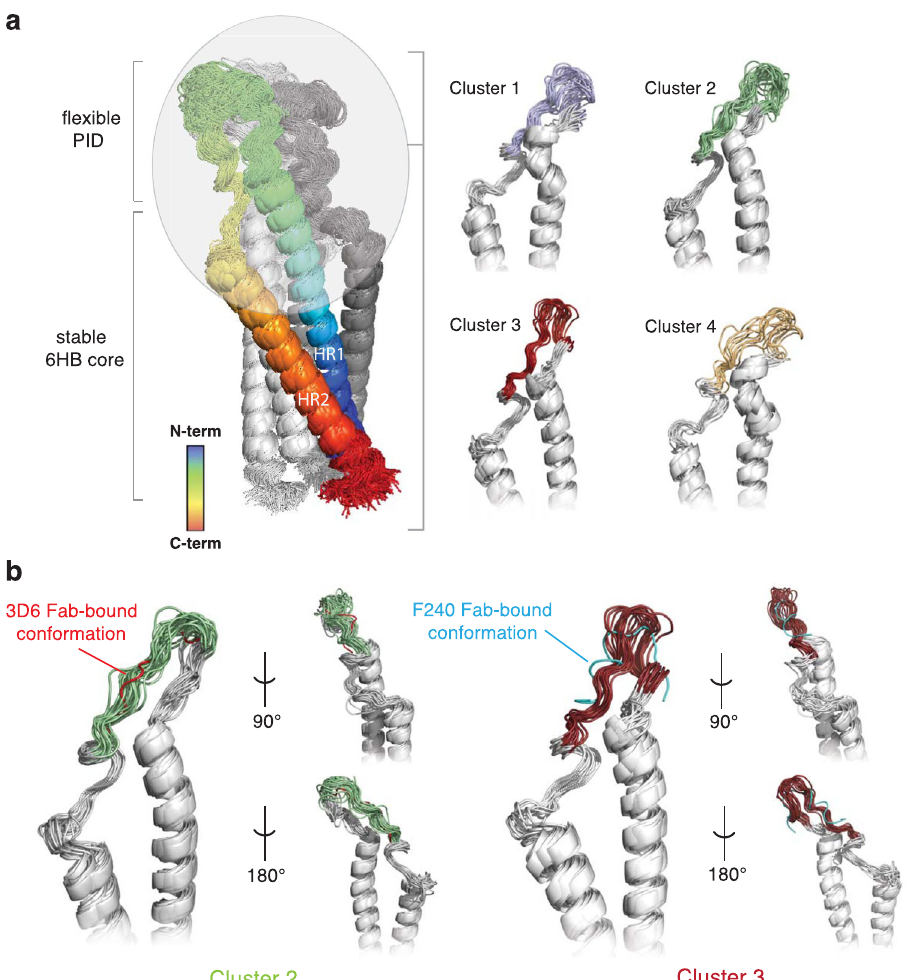
Fig. 7 Cluster analysis of the HIV-1 gp41 MD simulations. a Conformational fl exibility of PID motif in the context of the full-length gp41 ectodomain based on cluster analysis of a 200-ns MD simulation. The cartoon is colored as a chainbow from blue (N-terminus) to red (C-terminus). The conformations sampled by unbound PID were clustered using backbone RMSD-based hierarchical average linkage clustering with a merging distance cutoff of 2 Å over the trajectory. Based on this cutoff, a total of four clusters were generated, with conformations in each cluster superposed. b The gp41 PID conformations observed in clusters 2 and 3 from one representative replicate are consistent with those observed in the Fab 3D6 (red) and F240 (cyan) complex